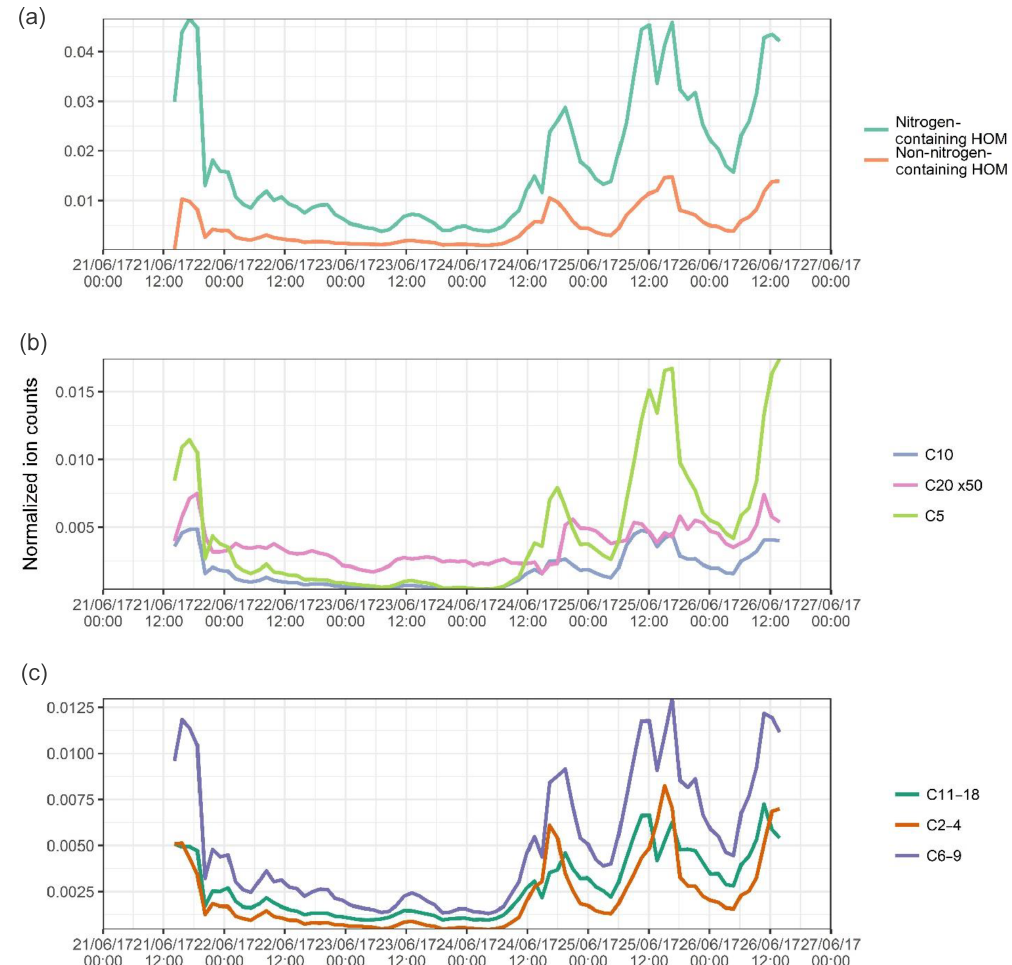
Figure 3. Summed time series of the normalized signals of (a) all non-nitrogen-containing HOMs and all organonitrates identified; (b) C 5 , C 10 , and C 20 components, assumed to be dominated by isoprene, monoterpene monomer, and monoterpene dimers, and signal for C 20 multiplied 50 times to fit scale; and (c) summed C 6 –C 9 components and summed C 11 –C 18 components, assumed to be dominated by alkylbenzenes and other larger components